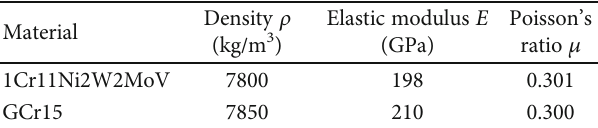
Table 1: Material properties of 1Cr11Ni2W2MoV and GCr15 at room